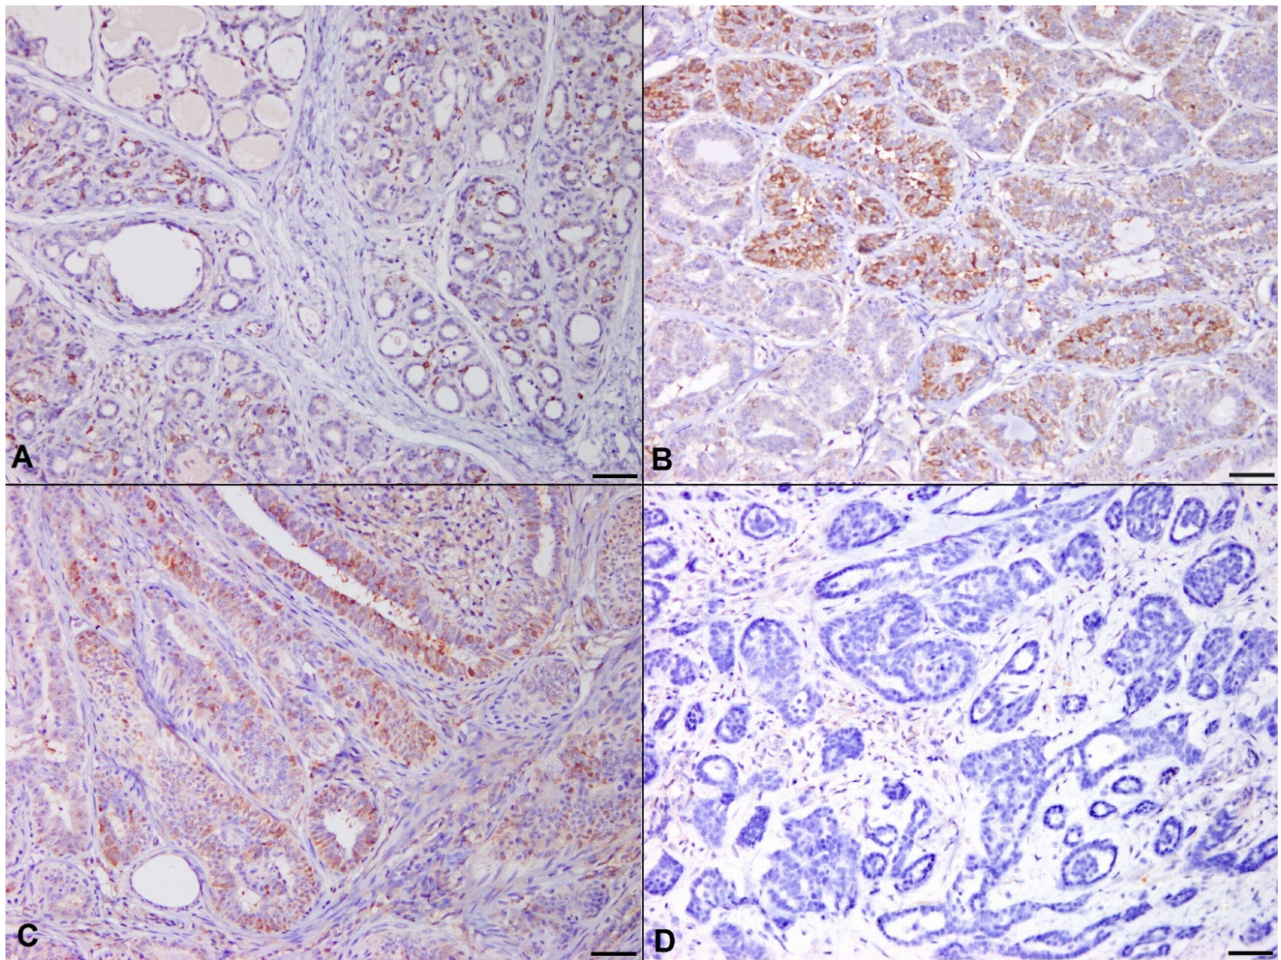
Figure 4. Immunohistochemistry for PTEN. ( A ) Normal mammary gland. Positivity for PTEN was found in